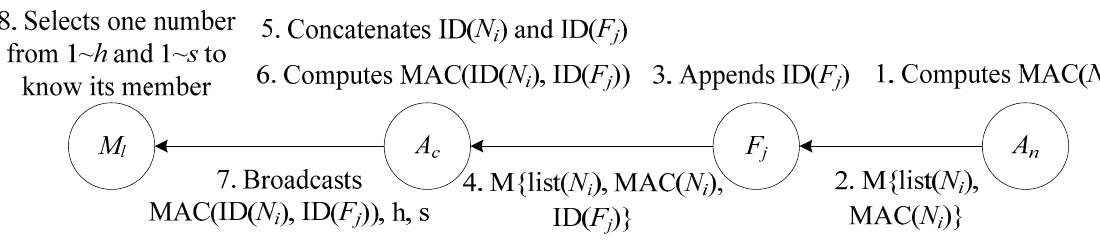
Figure 3. The message transmission process in the formation of